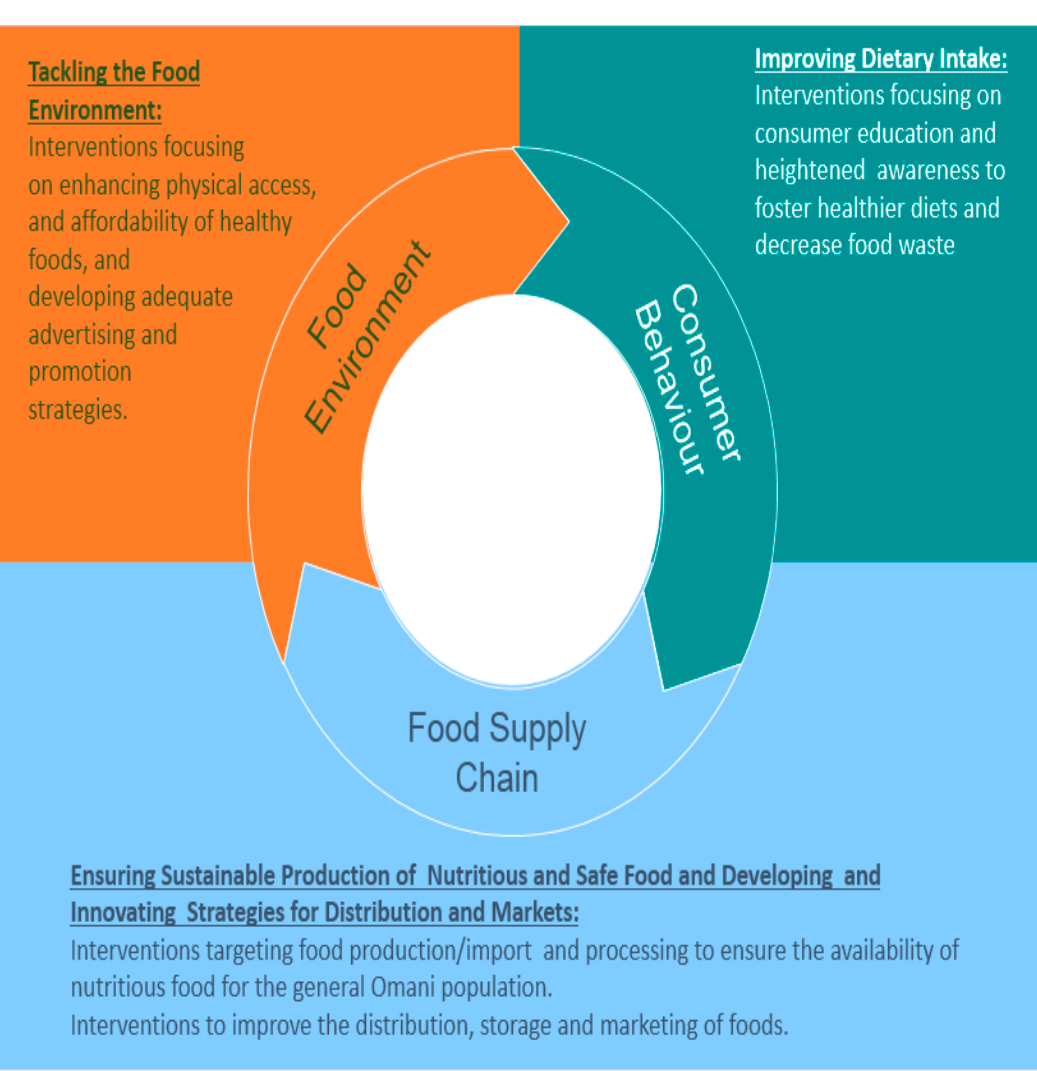
Figure 4. The three constituent elements of food systems and the entry points for intervention [6].